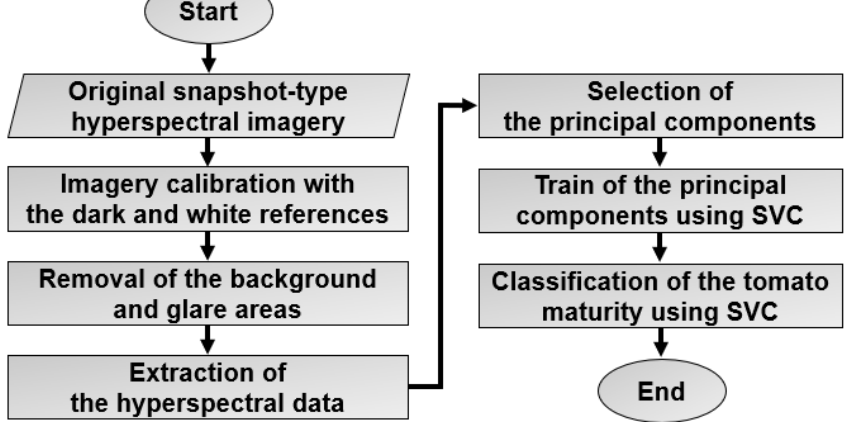
Figure 3. The flowchart diagram for classifying the tomatoes’ maturity stages from the snapshot-type hyperspectral imagery.